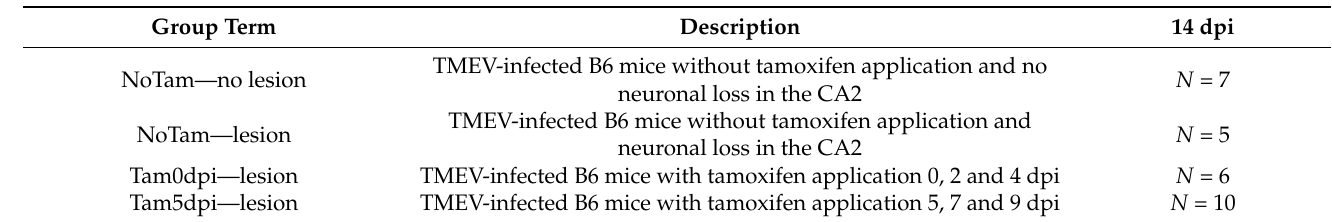
Table 1. Summary of the different groups of TMEV infected mice that were sacrificed 14 days post-infection (dpi), divided by tamoxifen treatment and presence of neuronal loss (lesion) in the CA2 of the hippocampus. The NoTam-groups contain CreER+/ − as well as CreER − / − mice. There was no difference in the occurrence of hippocampal lesions in untreated mice with or without CreER-expression ( p =